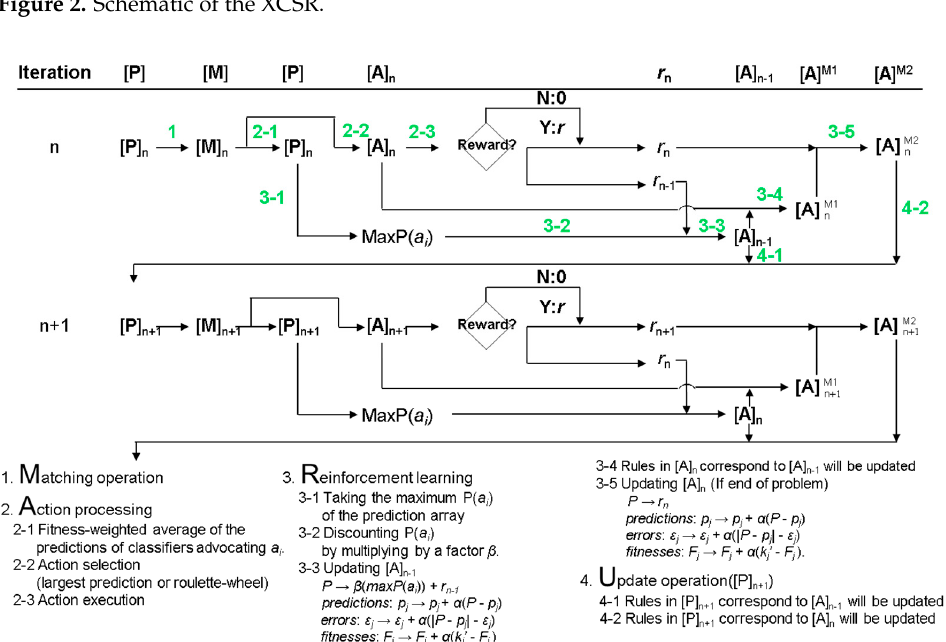
Figure 3. Flowchart of the XCSR in stage n.